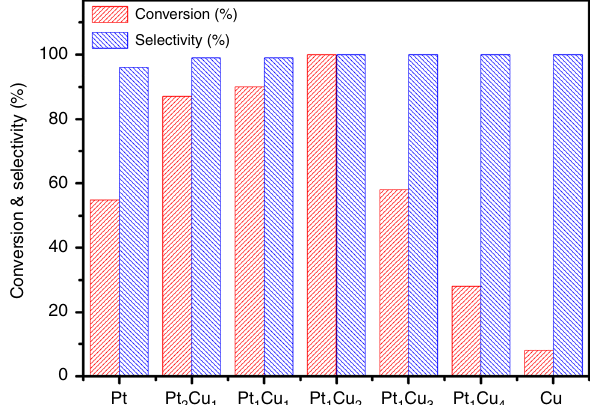
Fig. 5 Oxidation of benzyl alcohol over PtCu@MIL-101 catalysts. Conversion and selectivity of catalytic oxidation of benzyl alcohol over PtCu@MIL-101 catalysts with different Pt/Cu molar ratios. Reaction conditions: catalyst (100 mg), alcohol (0.2 mmol), H 2 O (5 mL), O 2 (0.5 MPa), 373 K, reaction time for each run is 5 h